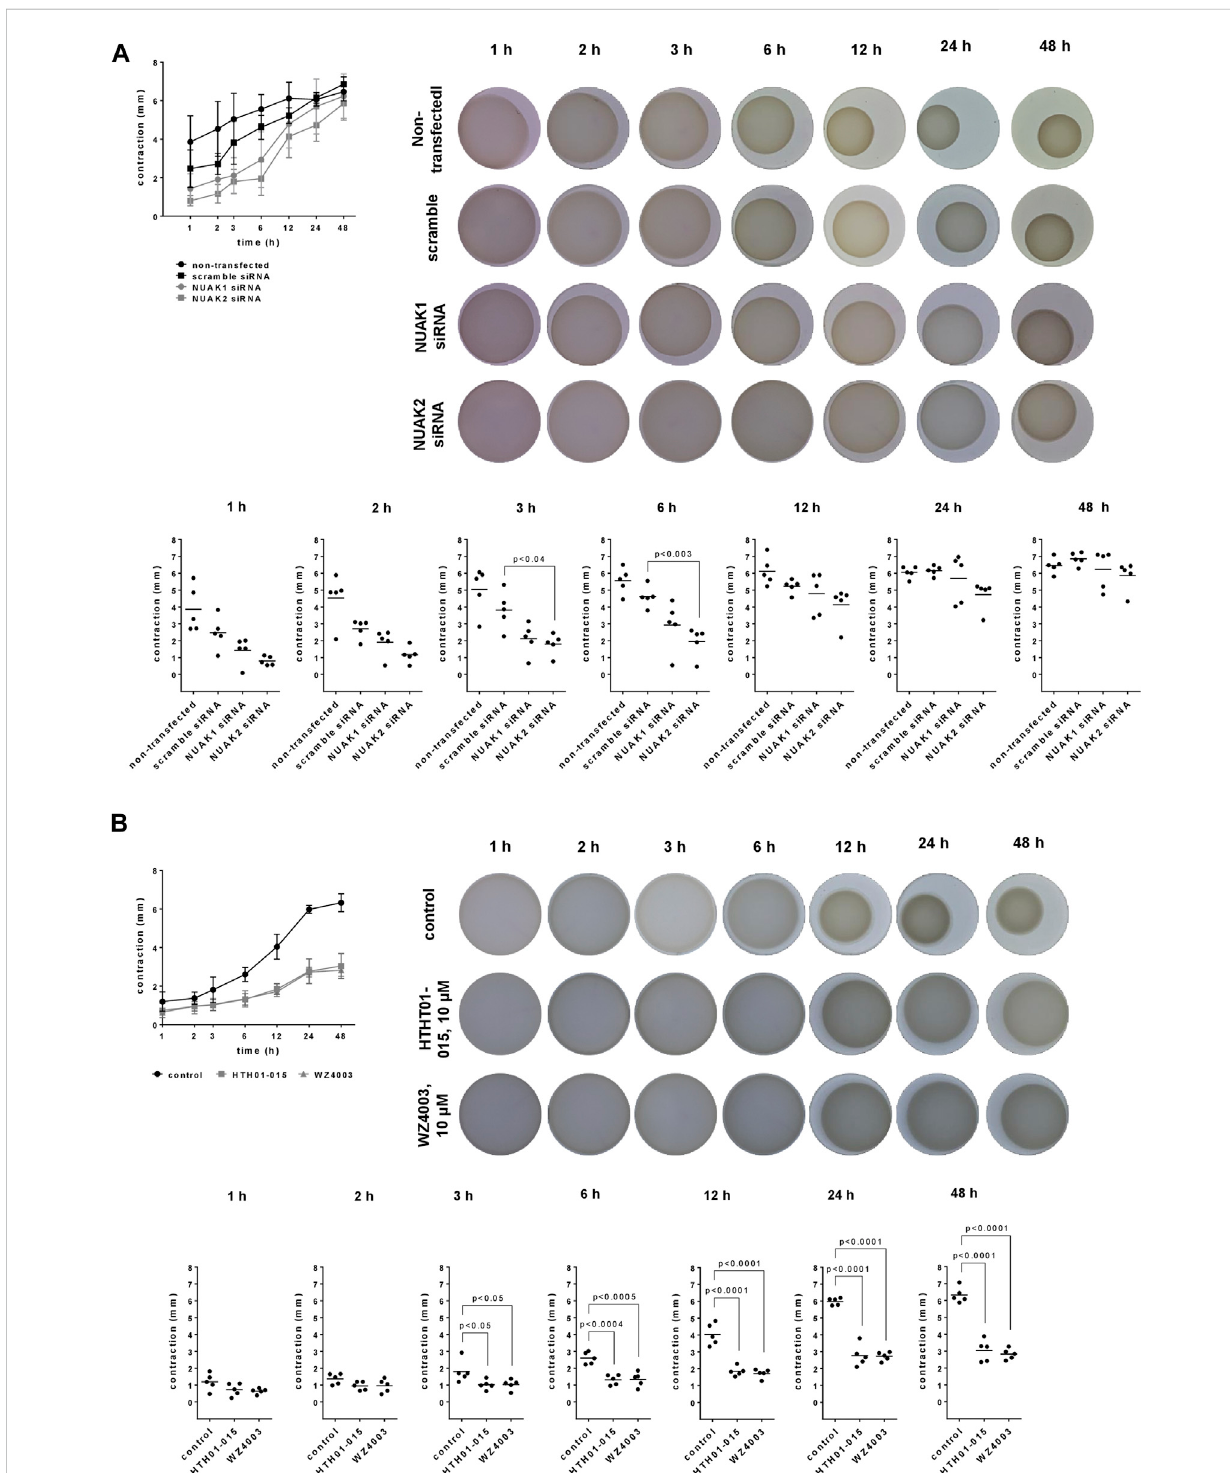
FIGURE 2 EffectsofNUAKsilencing,HTH01-015andWZ4003oncontractionofWPMY-1 cells.ContractionofWPMY-1 cellsovertimewasassessedbymatrix contraction, starting 48 h after transfection with scramble siRNA or isoform-speci fi c NUAK siRNAs (A) , or starting 24 h after addition of HTH01-015 (10 µM), WZ 4003 (10 µM) or solvent to controls (B) . Contractions are expressed as decreases in plug diameter during indicated periods. Shown are contractions overtime (means with SD), representativepicturesfor each condition, and single values fromeach sample and each single experiment for each time point in scatter plots, including p values from one-way ANOVA with Tukey ’ s test in (A) and one-way ANOVA with Dunnett ’ s test in (B)